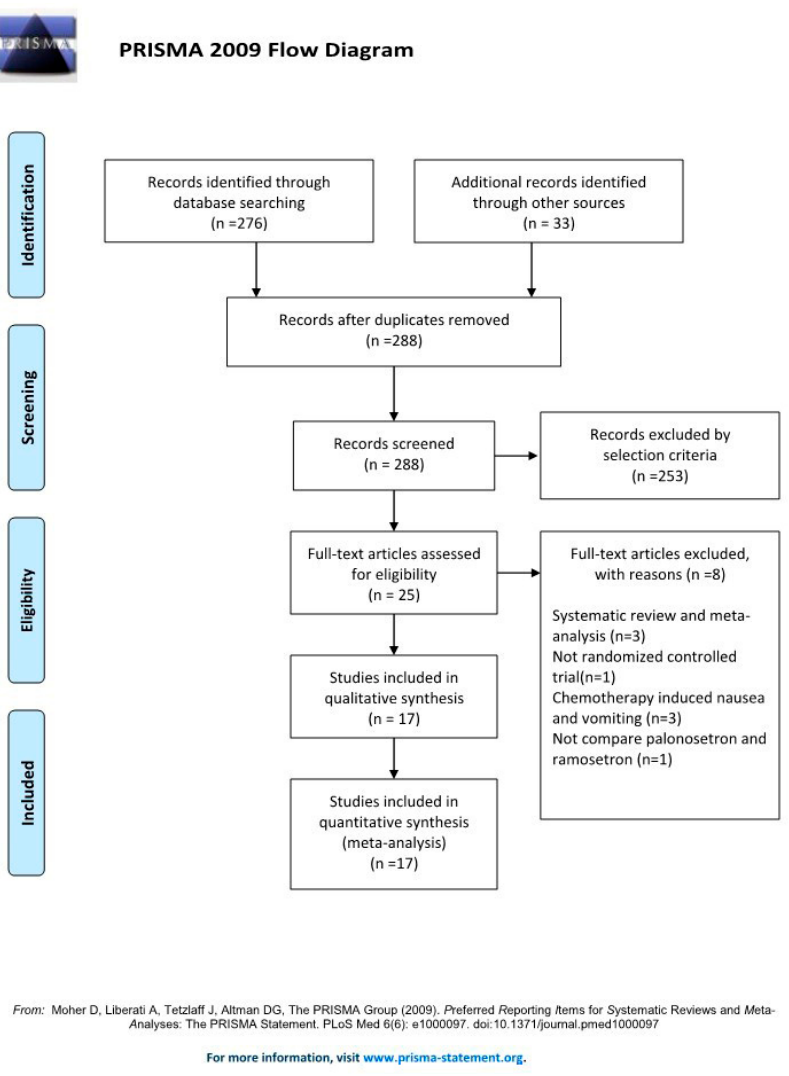
Figure 2. PRISMA flow diagram of the search for randomized controlled trials and the inclusion and exclusion criteria [10].